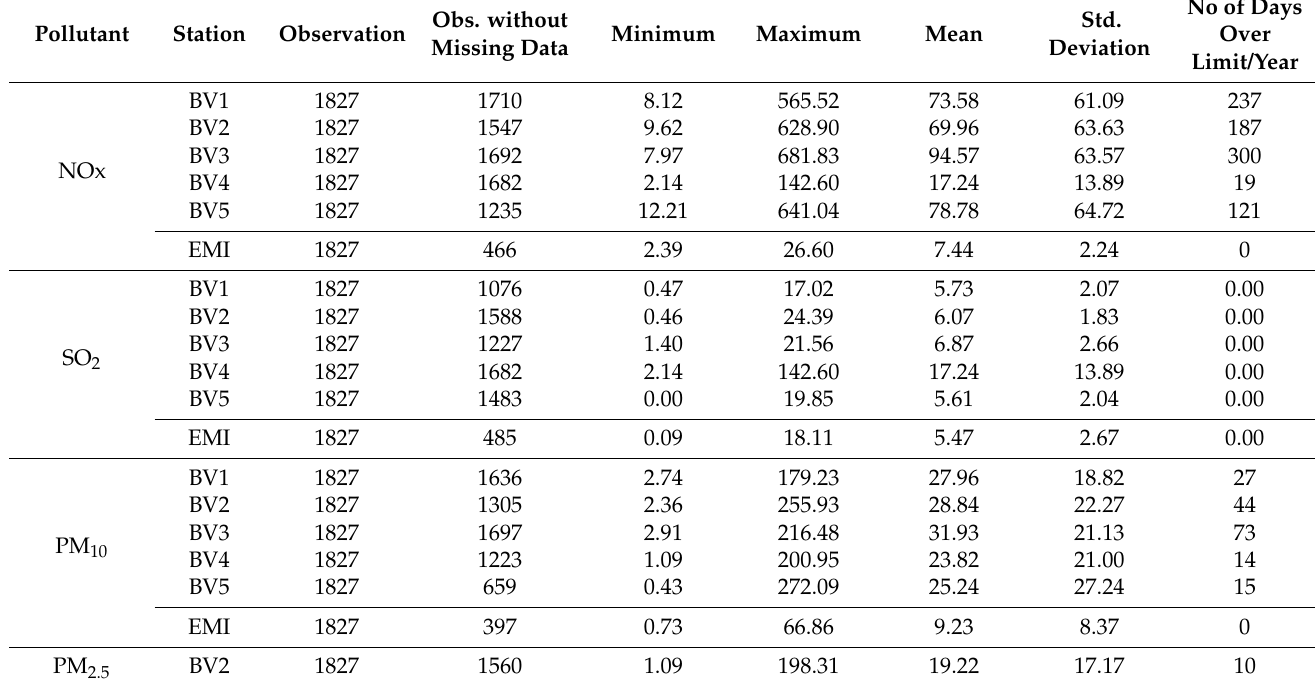
Table 5. Statistical analysis of daily principal pollutants investigated.